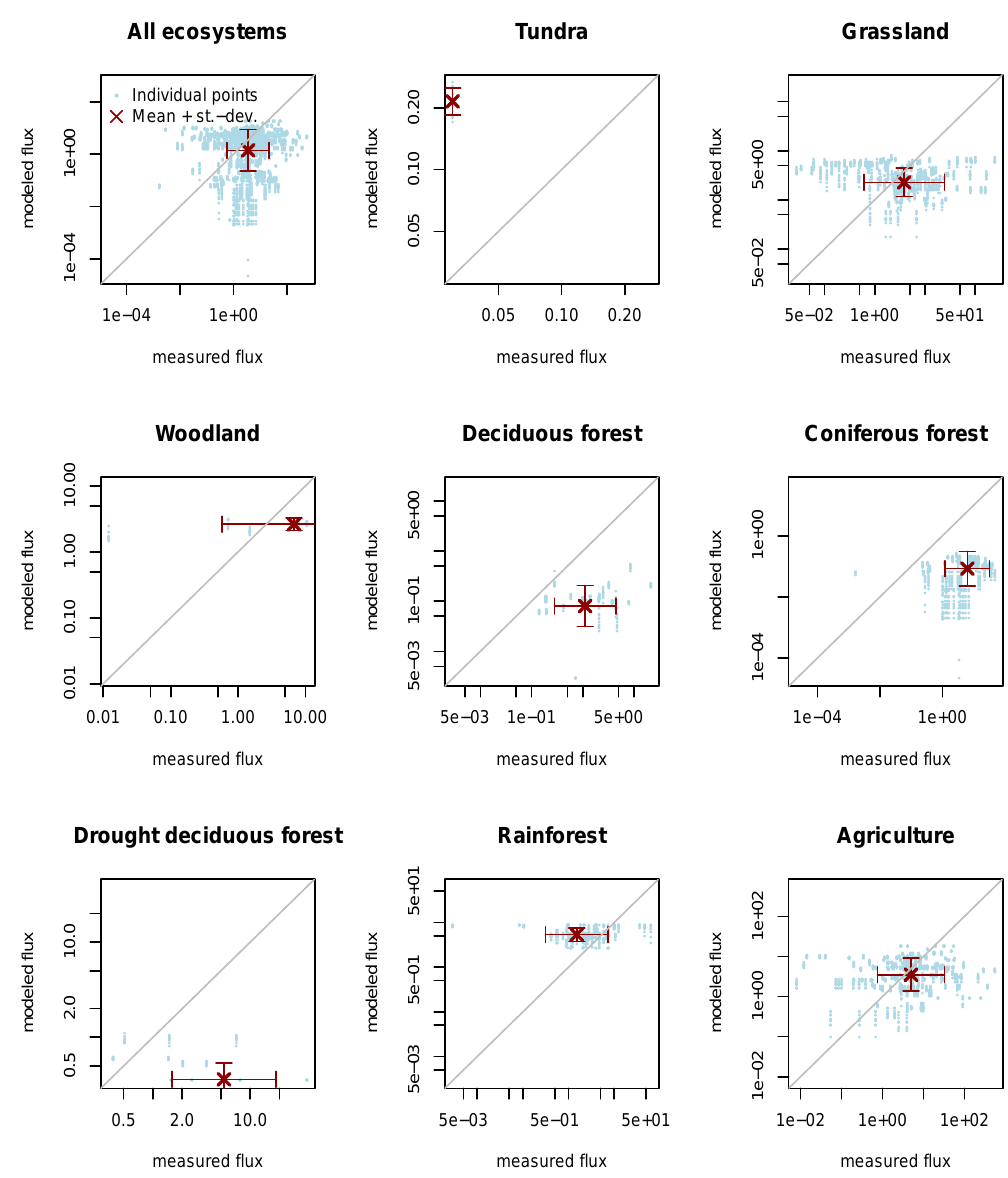
Fig. 4. Scatterplot of simulated SNO x in YL95EMAC for each corresponding period of the year versus each measurement along with the mean values and standard